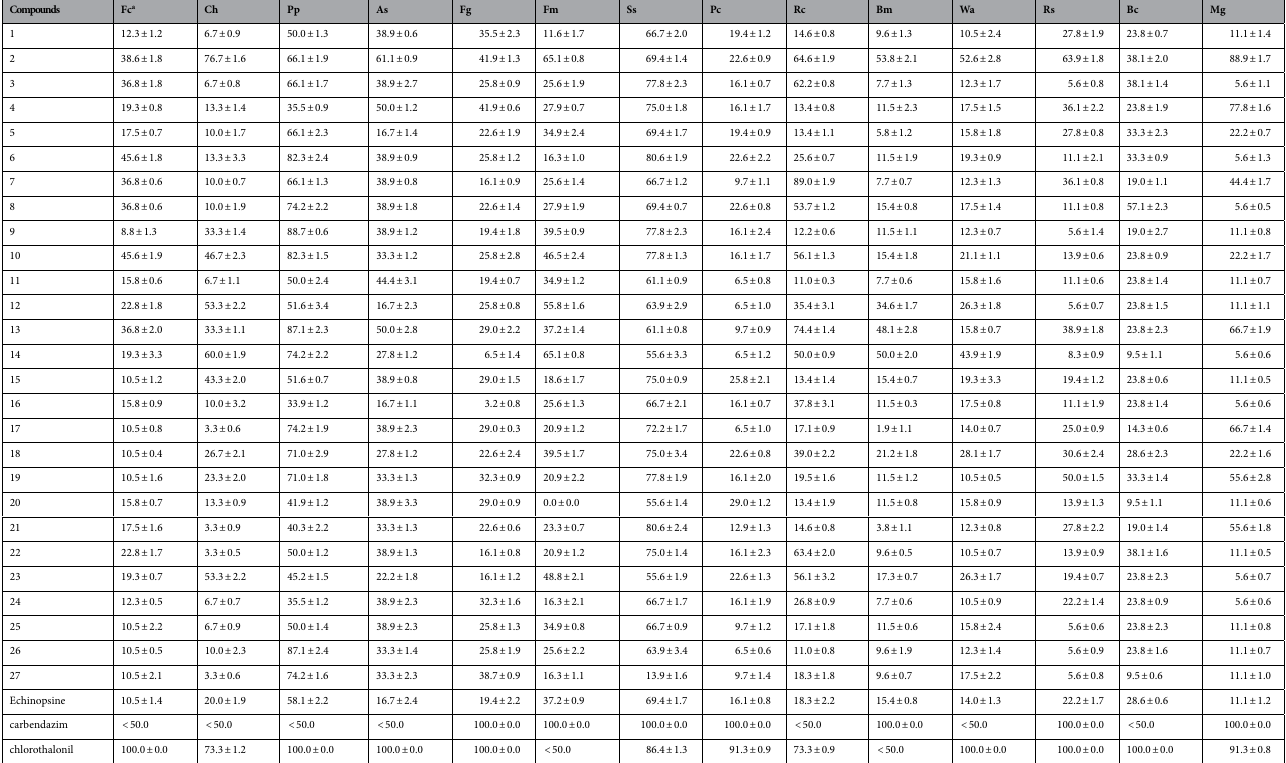
Table 4. Fungicidal activity of compounds 1 – 27 and echinopsine against fourteen kinds of phytopathogens (50 mg/L, inhibition rate/%). a Fc, Fusarium oxysporium f. sp. cucumeris; Ch, Cercospora arachidicola Hori; Pp, Physalospora piricola; As, Alternaria solani; Fg, Fusarium graminearum; Fm, Fusarium moniliforme; Ss, Sclerotinia sclerotiorum; Pc, Phytophthora capsici; Rc, Rhizoctonia cerealis; Bm,Bipolaris maydis; Wa, watermelon anthracnose; Rs, Rhizoctonia solani; Bc, Botrytis cinereaand; Mg, magnaporthe grisea